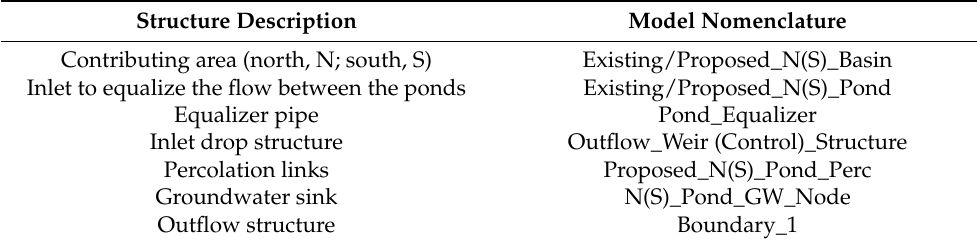
Table 3. Model structure description and